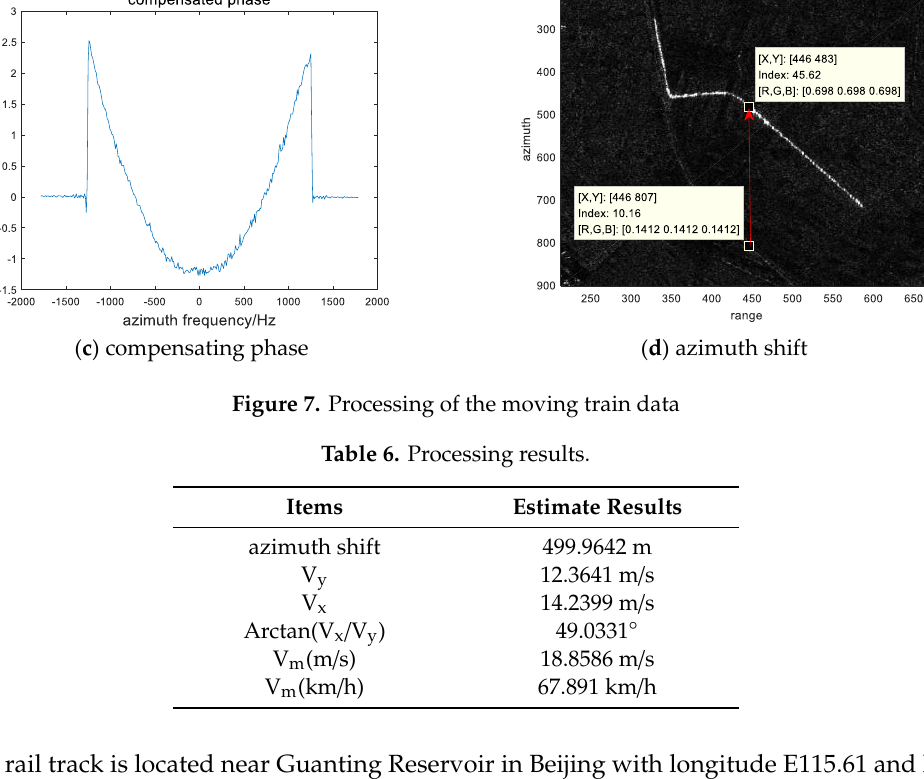
( f ) Azimuth shift Figure 6. Processing result of moving target. Table 4. Velocity estimation results. V